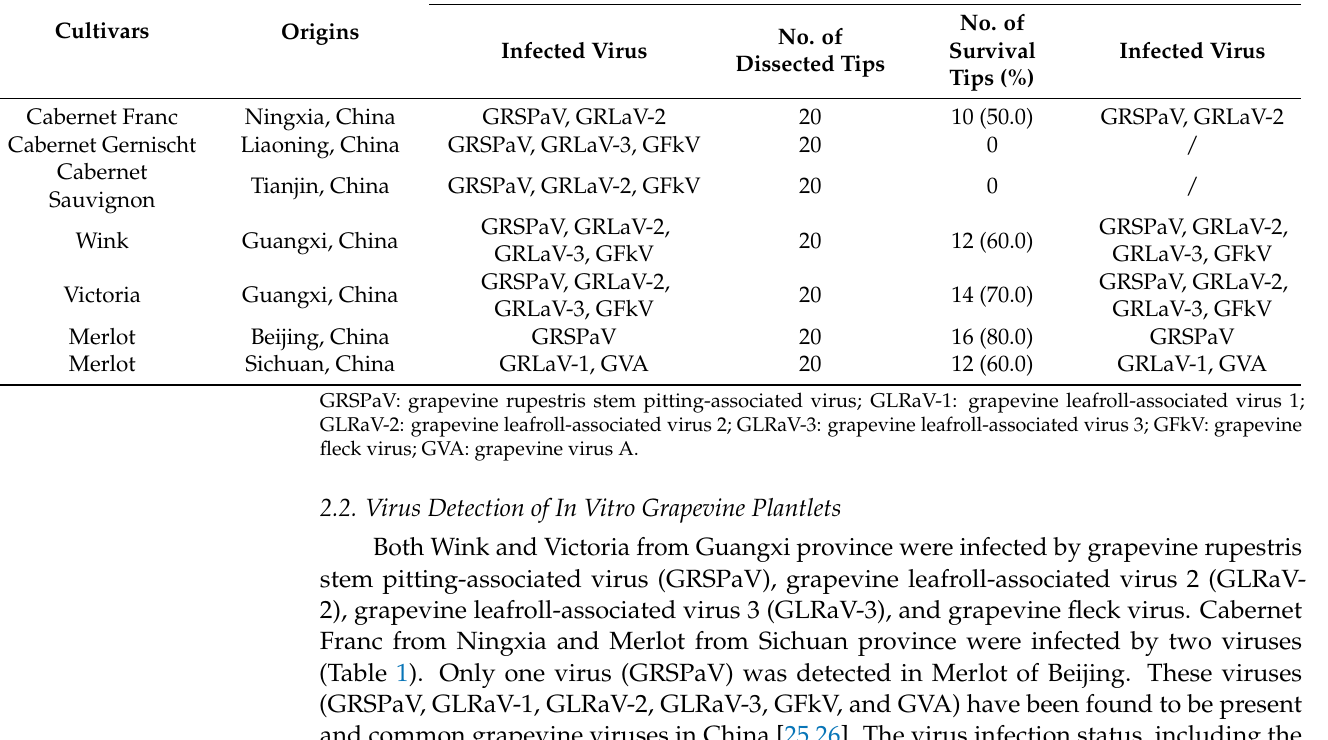
Table 1. The survival and virus infection status of regenerated grapevine plants.